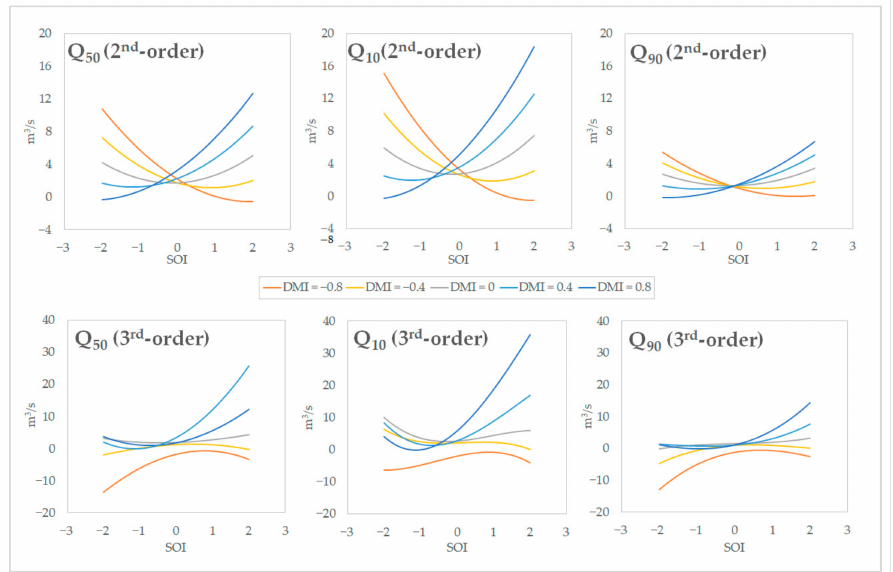
Figure 6. Dummy simulations of second- and third-order multiple regression (6-month moving average) to show the modulation effect of DMI to SOI–streamflow relationship produced by the models. Dummy dataset of DMI ( − 0.8 to 0.8) and SOI ( − 2.0 to 2.0) were used in these